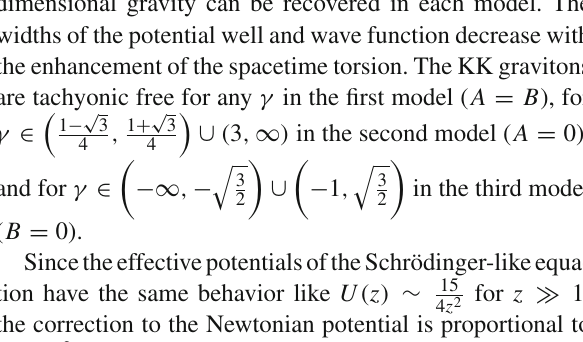
≈ 1 . 684 G / k . The 4 0